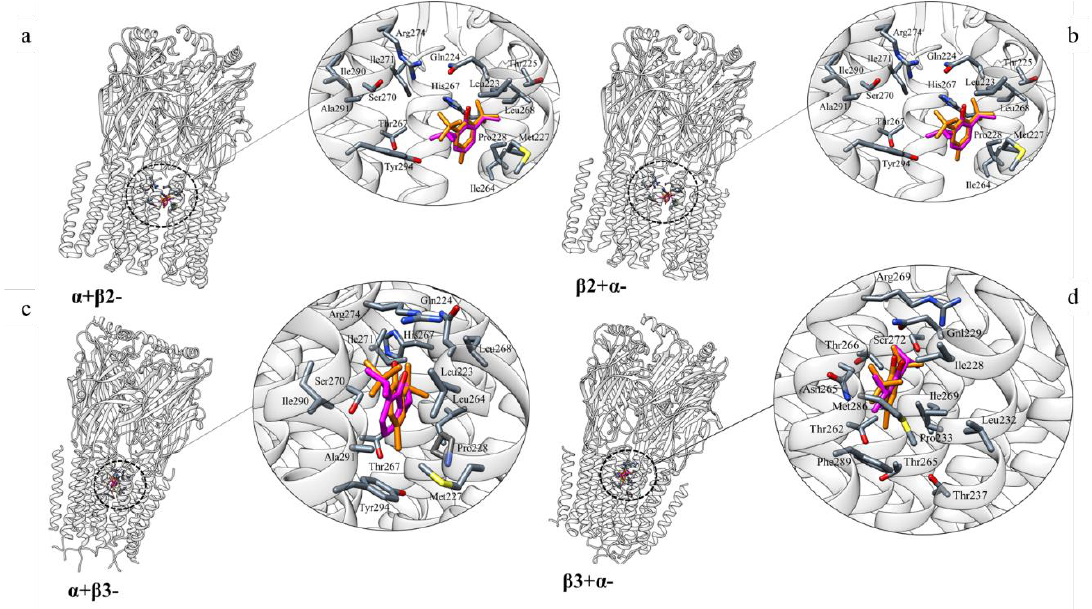
Figure 1. Molecular docking results for the GABA-AR–BHT interaction and the GABA-AR–PFL interaction (BHT and PFL are coloured in orange and magenta, respectively; protein residues are coloured by atom type); α1β2γ2 subtype, panels ( a , b ); α1β3γ2 subtype, panels ( c , d ).